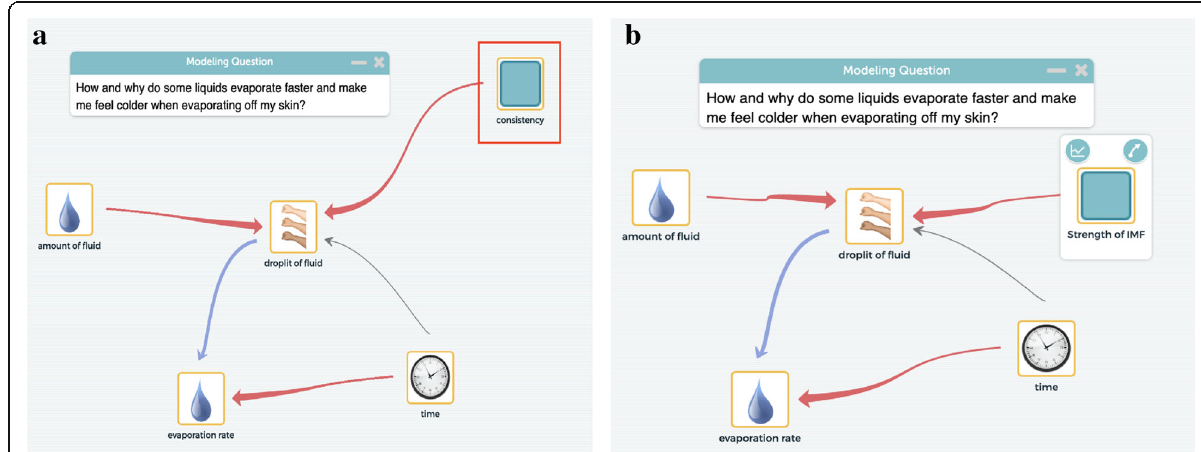
Fig. 4 Engagement of CT problem decomposition through activities of discussing DQ and observing various phenomena (recreated based on classroom discourse). Note. DQ. Driving question. a Element present in initial model. Note: Elements in an initial model by observing an anchoring phenomenon, discussing DQ, and developing paper-pencil models. b Element present in revised model. Note: Select key elements by deleting irrelevant ones and adding new ones through experiencing various phenomena through new investigation and revisiting